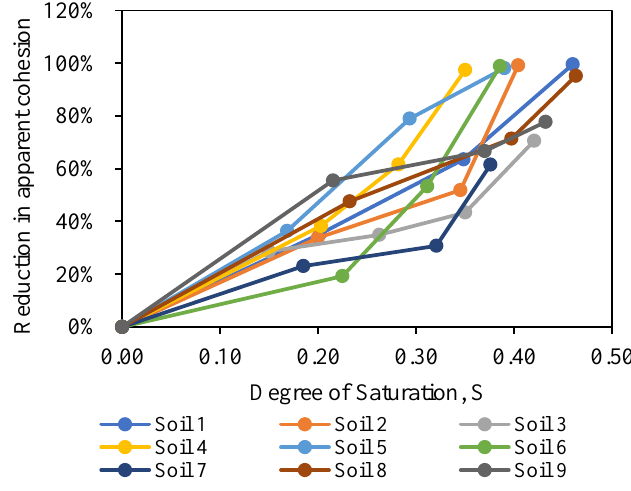
Figure 2. Reduction of apparent cohesion vs. degree of saturation. Table 2. Comparison of shear strength parameters. Soil